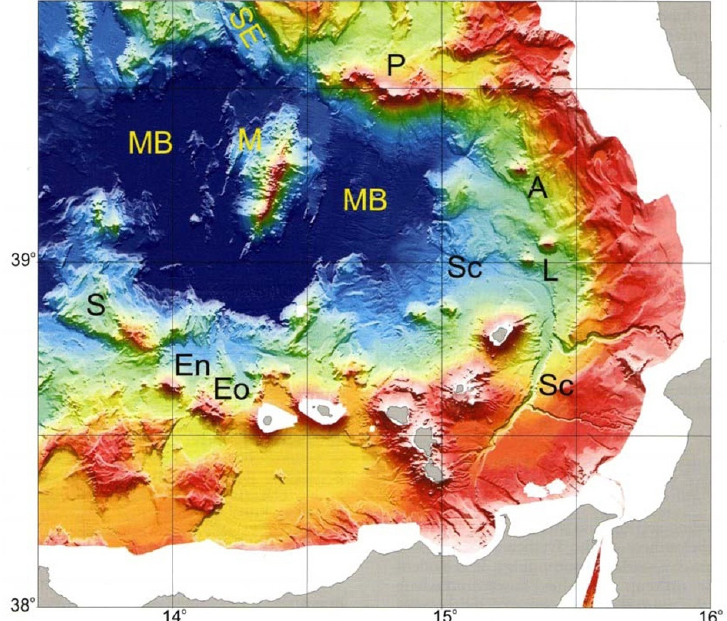
Figure 2. Bathymetry of South-Eastern Tyrrhenian Basin. M: Marsili; MB: Marsili Basin; P: Palinuro; A: Alcione; L: Lametini; Sc: Stromboli Canyon; Eo: Eolo; En: Enarete; S: Sisifo (modified after